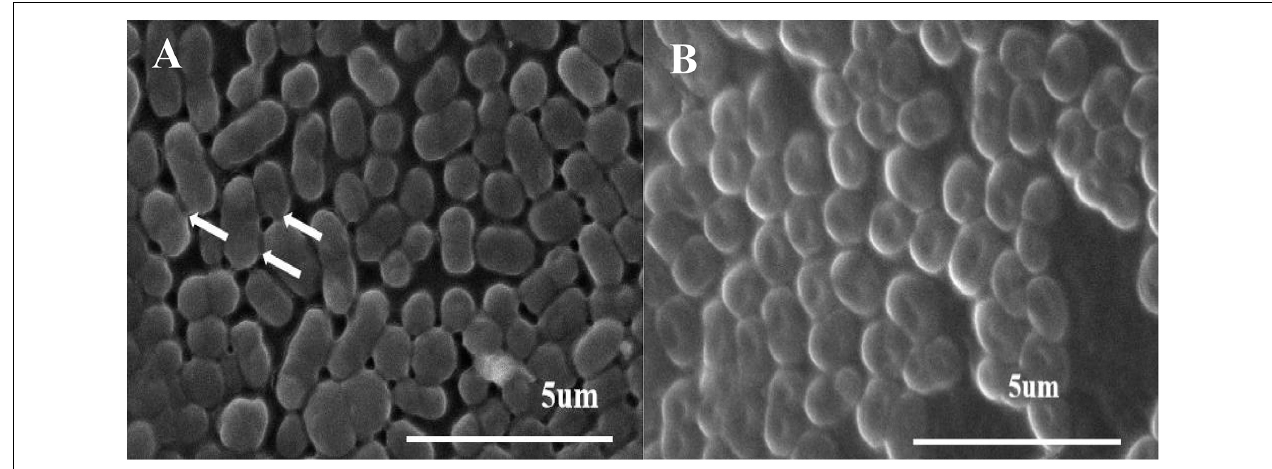
FIGURE 2 | SEM micrographs of strain DW-1 after incubation for 12 h (A) and 24 h (B) .